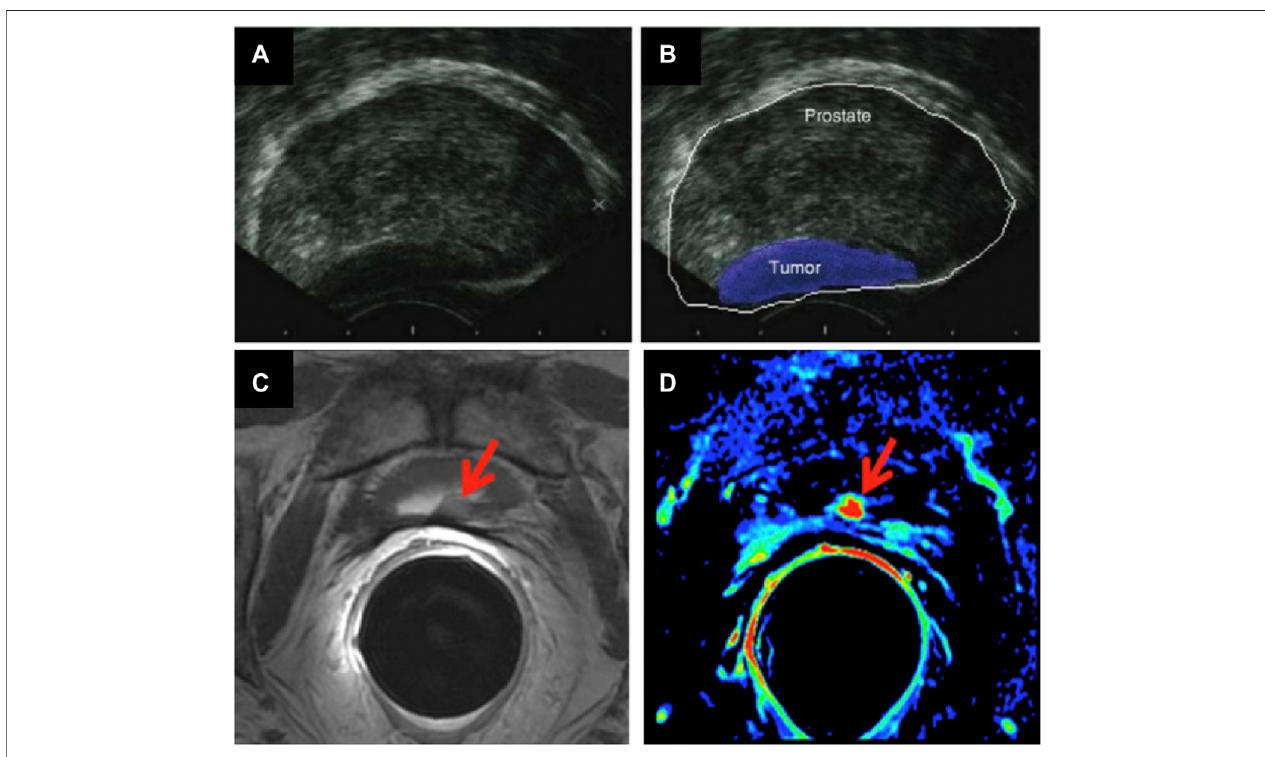
FIGURE 1 | (A,B) TRUS images of a prostate affected by cancer ( fi gure adapted from (Theodorescu and Ehdaie, 2009)); and MRI images of the prostate gland, showing cancerous regions (arrows): (C) Axial T2-weighted fast spin-echo image and (D) axial gradient-echo T1-weighted colour map image ( fi gure adapted from ( Maurer et al., 2016 )).